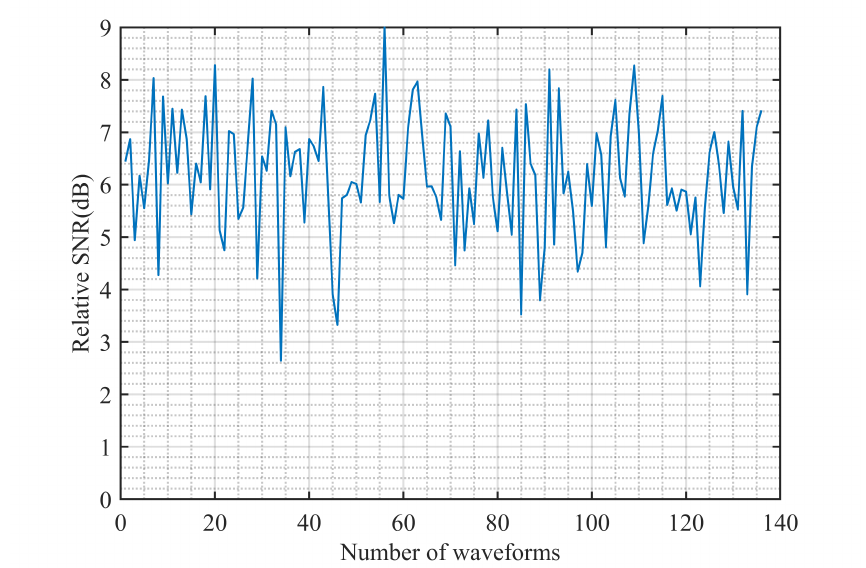
Figure 11. Relative SNR after and before PMEPR optimization.